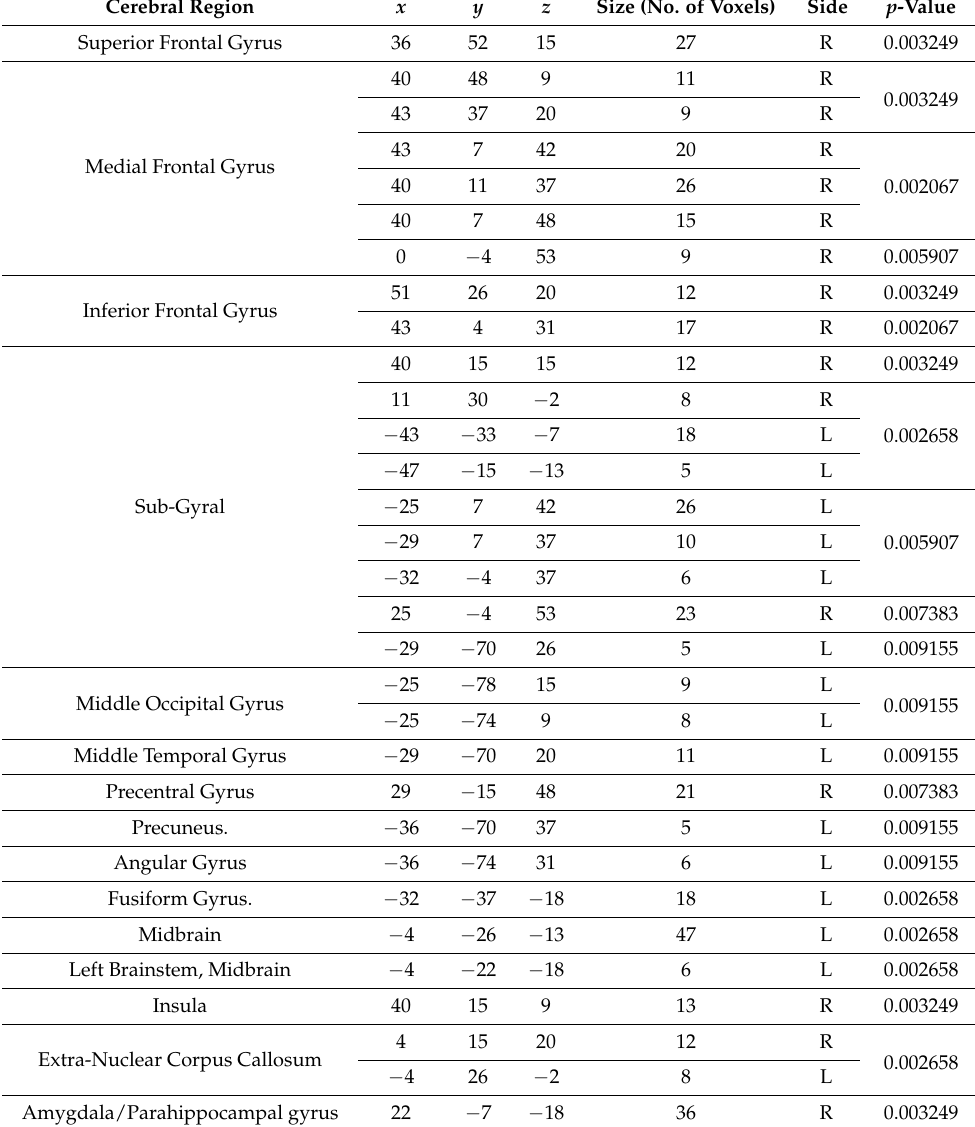
Table 4. Regions of brain activation (Talairach coordinates) showing significantly greater correlation with methylation percentage at CpG island 11–12 around rs1130233 polymorphism in the AKT1 gene under THC condition than under placebo condition while viewing fearful faces. L and R indicate the left and right